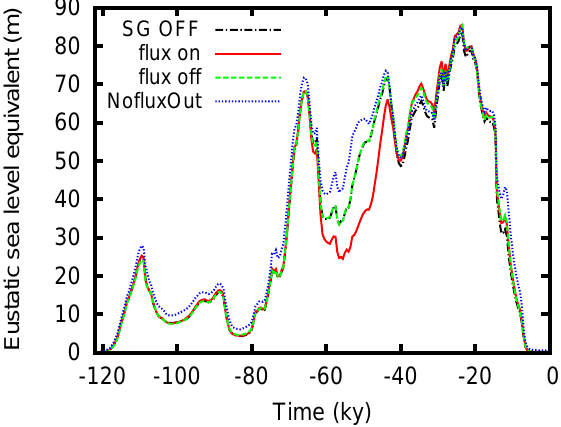
Figure 13. Total ice volume evolution for a simulation using pa- rameter vector nn9894. “flux on” and “flux off” both include the SG surface mass balance calculations but the latter has no SG ice fluxes. “NofluxOut” has SG on, but no SG ice flux between coarse grid cells. The “SG OFF” line is most of the time hidden under the “flux off” line.